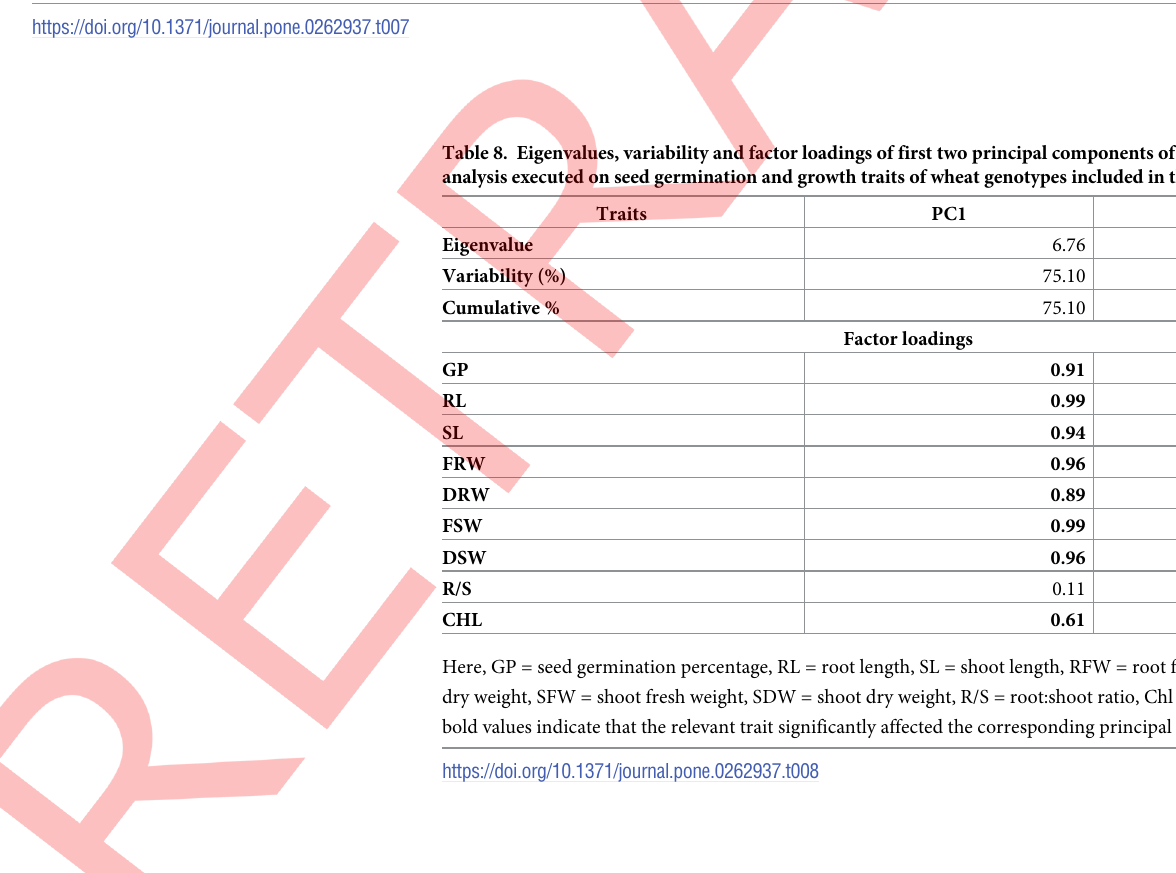
Table 8. Eigenvalues, variability and factor loadings of first two principal components of principal component analysis executed on seed germination and growth traits of wheat genotypes included in the study. Traits PC1 PC2